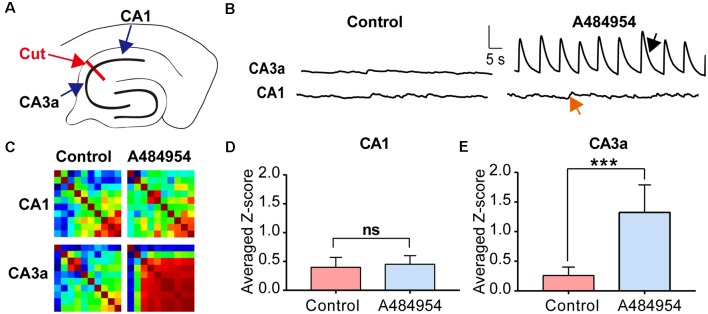
Investigation of the origin of synchronized fluorescence transients in the hippocampal–entorhinal slice after treatment with A484954 by uncoupling CA1 and CA3 region. (A) The sketch shows the uncoupling of CA1 and CA3 regions by a cut through the str. oriens, str. pyr, and str. radiatum (red line and arrow). The fluorescence changes were analyzed on both sites of the cut in the CA3 and CA1 regions. (B) Representative fluorescence transients are depicted for the indicated regions. Vertical scale bar: ΔF/F0 = 5, horizontal scale bar: 5 s. After uncoupling of CA1 and CA3, a synchronized activity of CA1 neurons after drug application was absent in the CA1 (red arrow) area but not in the CA3 region (black arrow). (C) The corresponding heat maps for before and after drug application of one representative experiment represent the same phenomenon as in (B). Whereas under control condition without uncoupling of CA1 and CA3 a synchronization after drug application was detectable, a synchronization was not observable after lesion of the CA1 from CA3 area. However, the CA3 region was still synchronized by the A484954 compound as indicated by the red-colored heat map. (D) The bar graph summarizes the result for the CA1 area from different experiments (control: 0.40 ± 0.17; A484954: 0.45 ± 0.15; ns, unpaired t-test, n = 8). (E) The bar graph summarizes the result for the CA3a area (control: 0.30 ± 0.14; A484954: 1.32 ± 0.47; ***P < 0.01, unpaired t-test, n = 8).